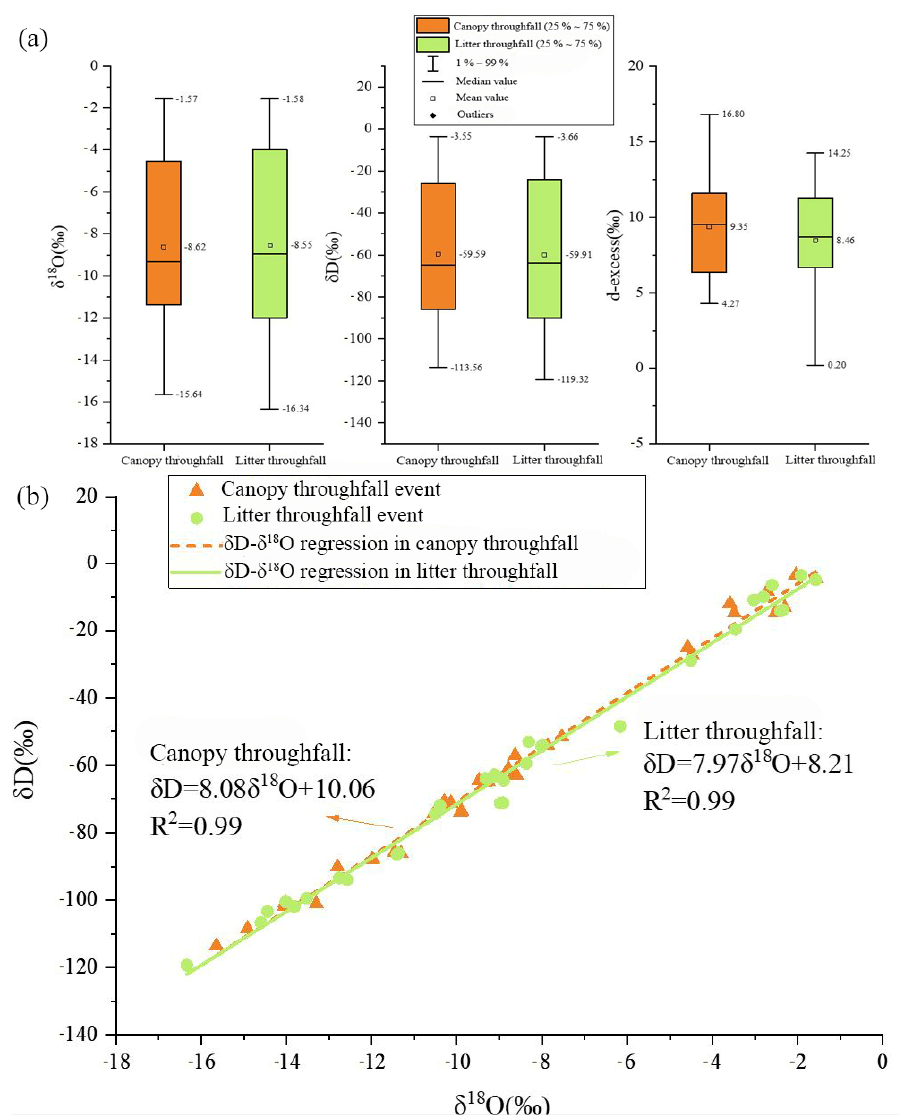
Figure 3. Isotopic comparison between canopy throughfall and litter throughfall: ( a ) box-plot of δ D, δ 18 O and d-excess; ( b ) δ D- δ 18 O regression lines.